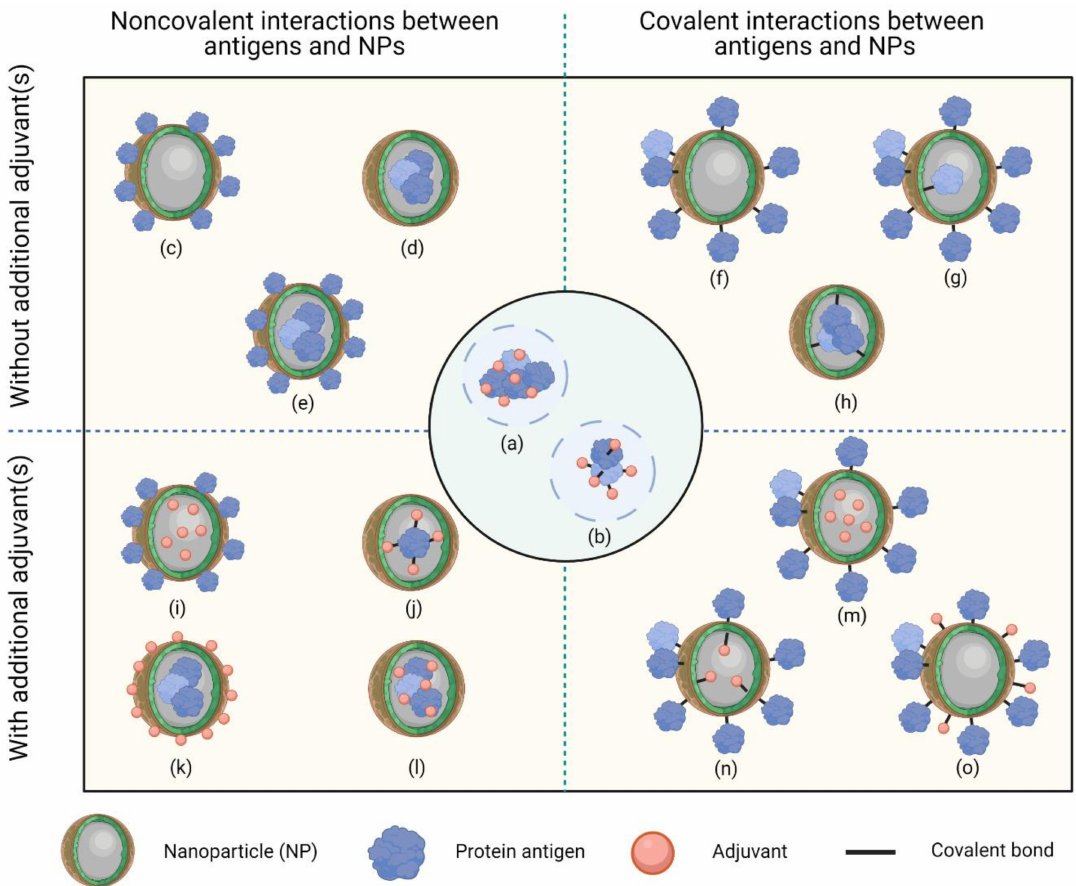
Figure 2. The most common designs of nanoparticle (NP)-based vaccines. Antigens can be associated with NPs via noncovalent interactions (left panels) or covalent interactions (right panels). Additional adjuvants can be incorporated into formulations to elicit stronger immune responses (bottom panels), or NPs can be administered on their own (top panels). ( a ) Antigen physically mixed with adjuvant through electrostatic or hydrophobic interaction. ( b ) Antigen conjugated to adjuvant via covalent bond. ( c ) Antigen coated onto the surface of NPs through electrostatic or hydrophobic interaction (in some cases, there may be multiple coating layers). ( d ) Antigen encapsulated in NPs. ( e ) Antigen coated onto the surface of NPs, as well as encapsulated within NPs. ( f ) Antigen conjugated to the outer surface of NPs. ( g ) Antigen conjugated to both the inner and outer surfaces of NPs. ( h ) Antigen conjugated to the inner surface of NPs. ( i ) Antigen coated onto the surface of NPs, with adjuvant encapsulated in the NPs. ( j ) Antigen–adjuvant conjugate encapsulated in NPs. ( k ) Adjuvant coated onto the surface of NPs, with antigen encapsulated in the NPs. ( l ) Mixture of antigen and adjuvant encapsulated in NPs. ( m ) Antigen conjugated to the surface of NPs, with adjuvant encapsulated in the NPs. ( n ) Antigen conjugated to the outer surface of NPs, with adjuvant conjugated to the inner surface. ( o ) Both antigen and adjuvant conjugated to the outer surface of NPs. NP, nanoparticle. Drawing created with Biorender.com (accessed 26 May